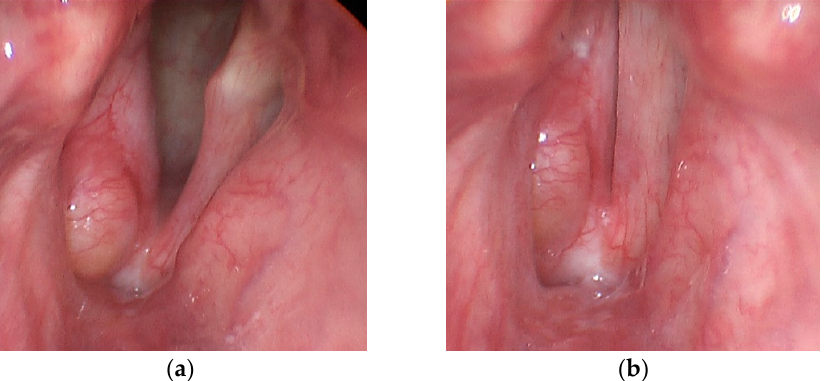
Figure 1. Endoscopic images of the larynx from the videostroboscopy examination of the participant who had previously undergone a unilateral (right vocal fold) hemilaryngectomy to treat laryngeal cancer. Shown are snapshots of the vocal folds in states of ( a ) abduction and ( b )